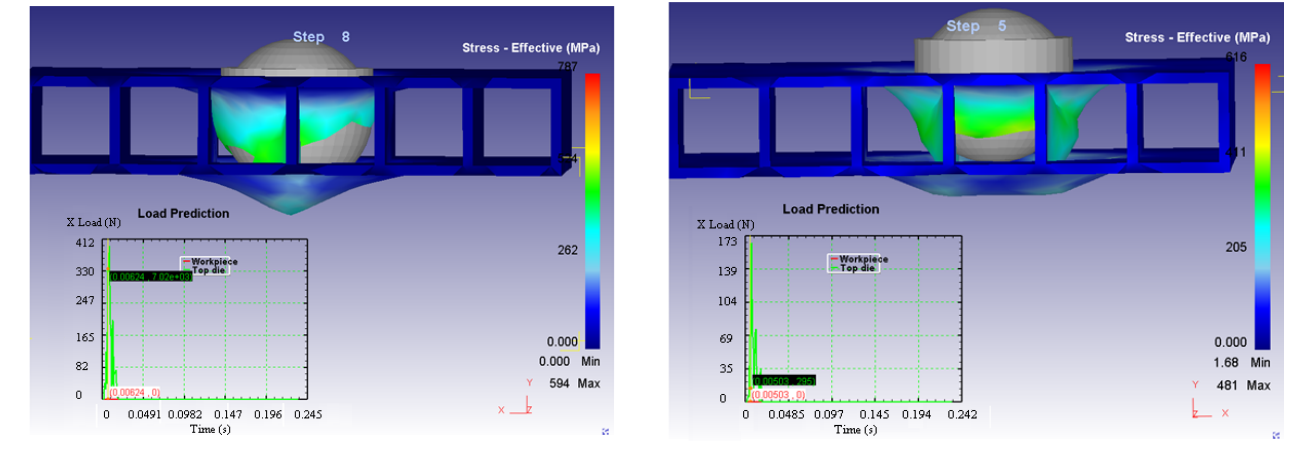
Figure 14. Stress-effective efforts—X axes in the two considered cases.